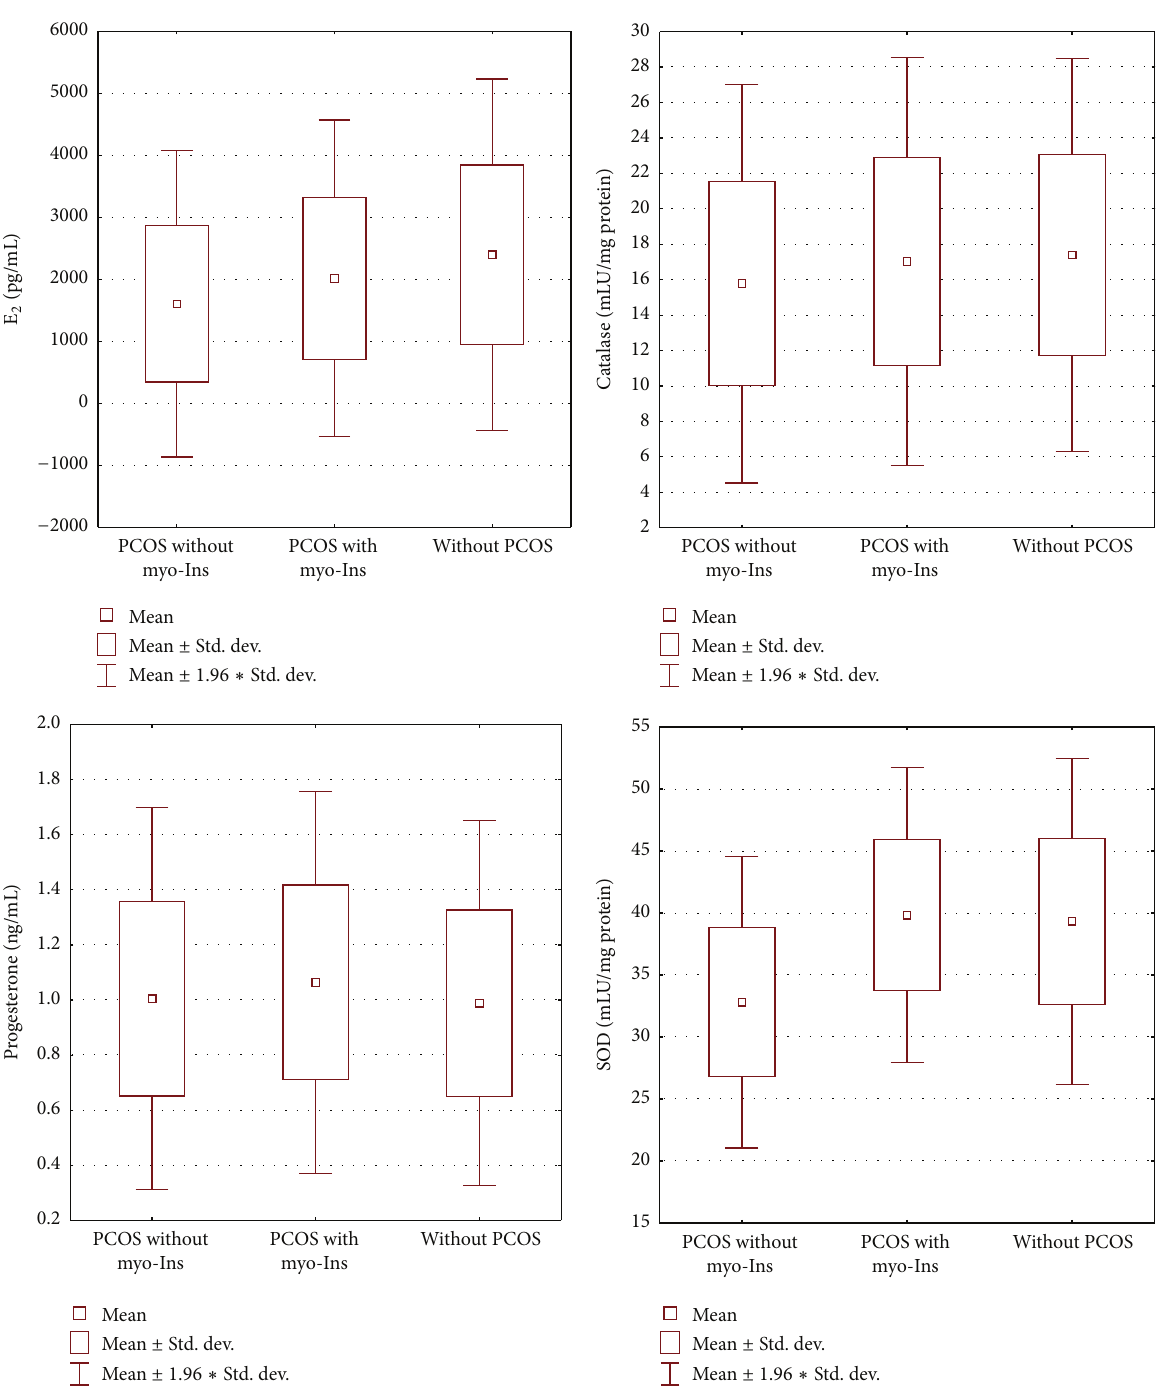
times, the increase in oestradiol level exerted a considerable influence on embryo developmental dynamics; however, no effect was observed in the remaining times. In group II, similar negative correlations concerned E 2 and 𝑡 1 ( 𝑟 = 𝑟 = −0.294 , 𝑝 = 0.035 ), 𝑡 𝑟 = −0.283 , −0.358 , 𝑝 = 0.009 ), 𝑡 3 ( 4 ( 𝑟 = −0.365 , 𝑝 = 0.008 ). In the other 𝑝 = 0.042 ), and 𝑡 5 (